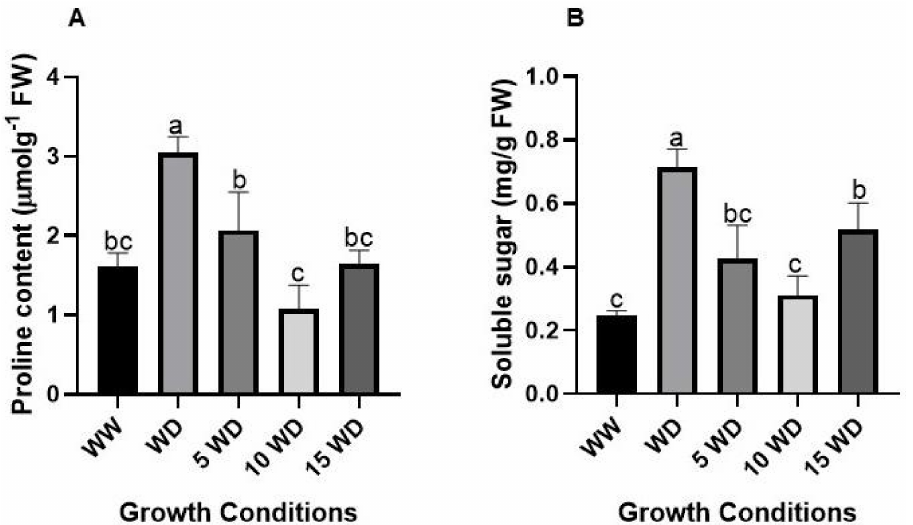
Figure 8. Effect of drought and α Fe 2 O 3 NP priming on osmolytes proline ( A ) and soluble sugar ( B ) content accumulation in sorghum. Error bars represent the SD calculated from three biological replicates. WW = well-watered (control); WD = water-deprived (drought stress); 5 WD = water- deprived + 5 mg/L α Fe 2 O 3 NPs; 10 WD = water-deprived + 10 mg/L α Fe2O 3 NPs, 15 WD = water- deprived + 15 mg/L α Fe 2 O 3 NPs. Data in the figure represent the mean ± standard deviation ( n = 3). Different letters indicate significant differences ( p < 0.05) based on ANOVA one-way variance analysis using Tukey’s comparison test.